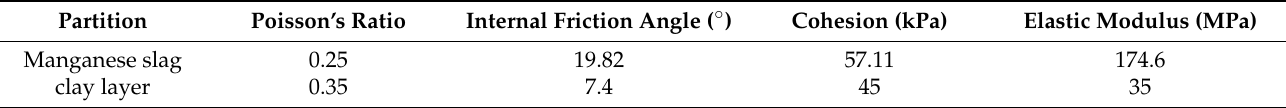
Figure 10. Envelope of consolidated undrained shear strength. Table 8. Parameters of stability calculation.